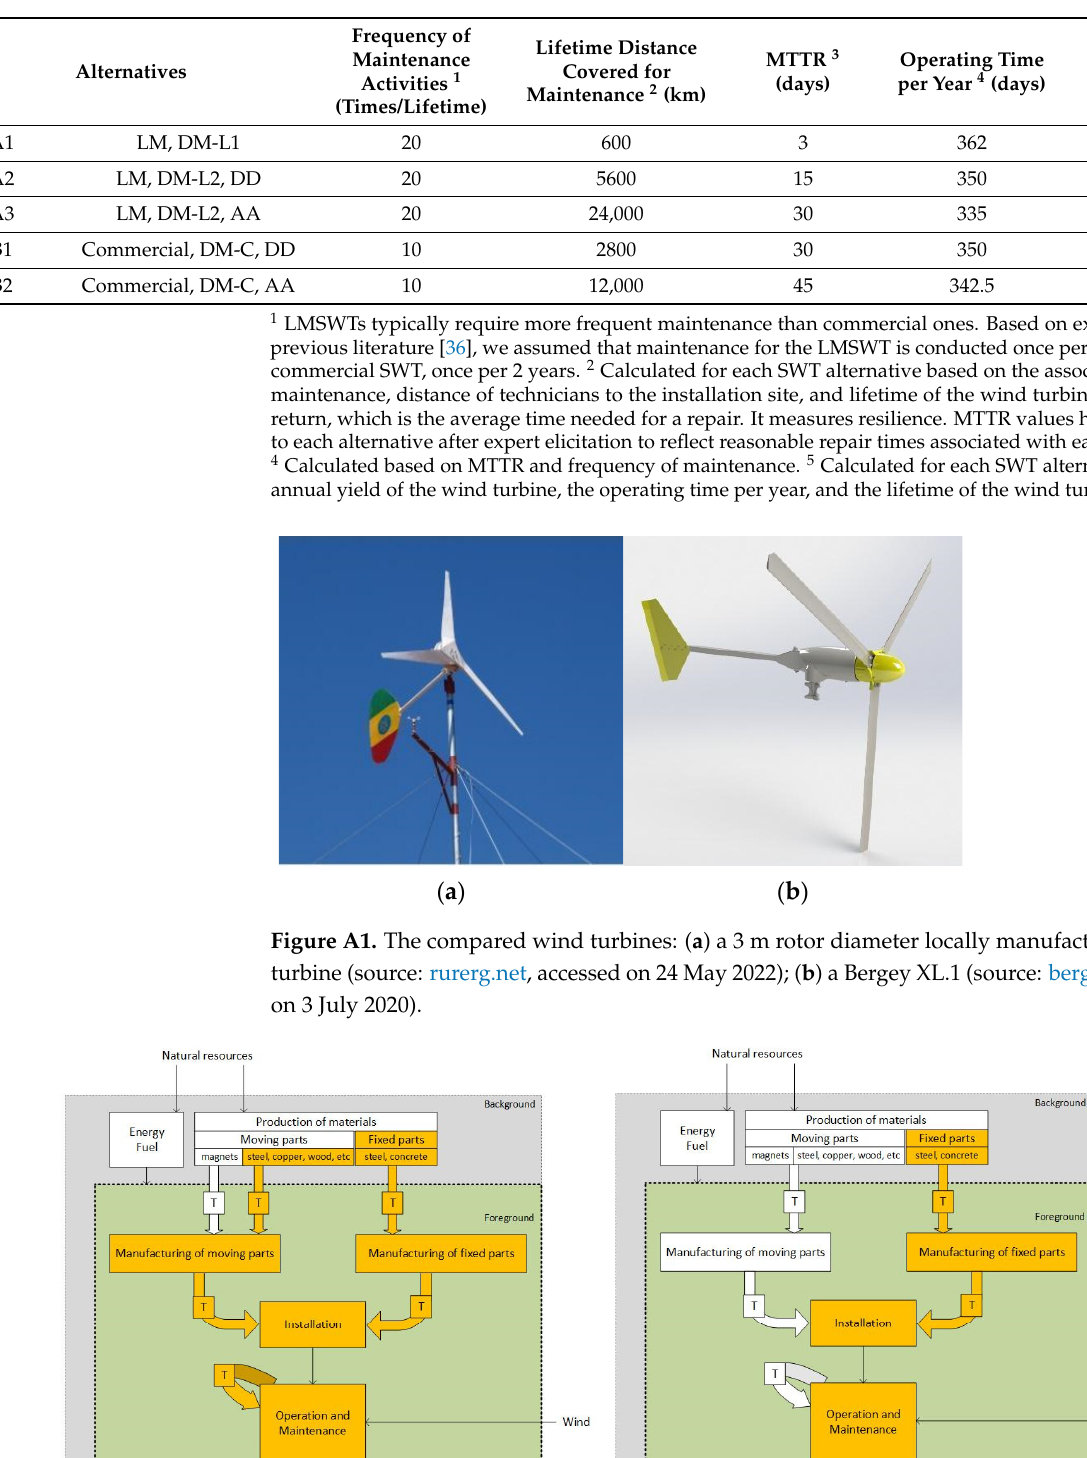
Table A2. Basic parameters for the five SWT alternatives.